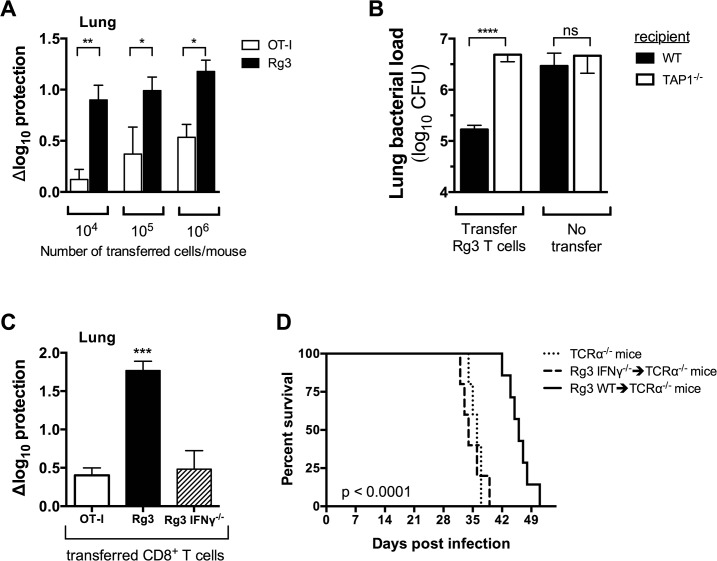
TAP1 and IFNγ are required for protection mediated by TB10-specific CD8+ T cells.(a,b) Bacterial burden in the lung 21 days after adoptive transfer of in vitro stimulated Rg (a,b) or OT-I (a) CD8+ T cells into sub-lethally irradiated, M. tuberculosis-infected C57BL/6J (a,b) or TAP-1 deficient (b) recipients. (c) Bacterial burden in the lung 21 d after adoptive transfer of in vitro stimulated Rg, IFNγ-/- Rg, or OT-I CD8+ T cells into sub-lethally irradiated, M. tuberculosis-infected C57BL/6J recipients. (d) Survival curves after adoptive transfer of naïve Rg or IFNγ-/- Rg CD8+ T cells into M. tuberculosis-infected TCRα-/- recipients. Transfers used 106 cells/mouse in “b” and “c” or 105 cells/mouse in “d”. Statistical significance calculated using the method of the Log-rank (Mantel-Cox) test. Data are representative from two independent experiments, each with at least 5 mice per group. Other statistical testing done by one-way ANOVA and ad hoc post tests. NS, not significant; *, p < 0.05.